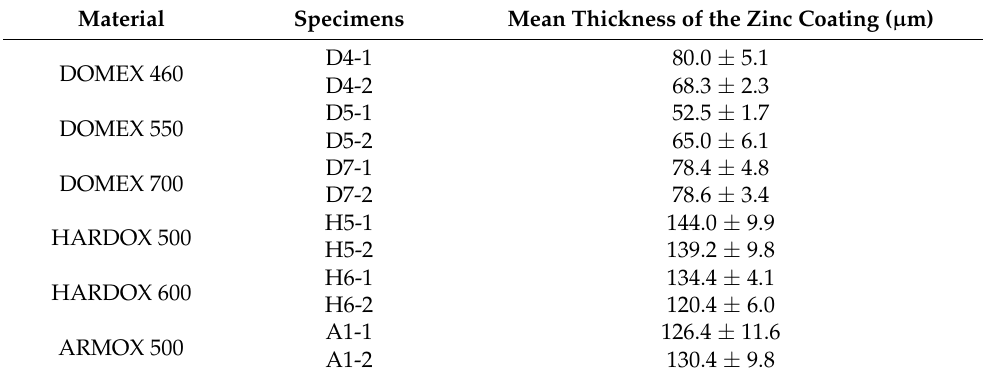
Table 6. The measured thickness of the zinc coating.